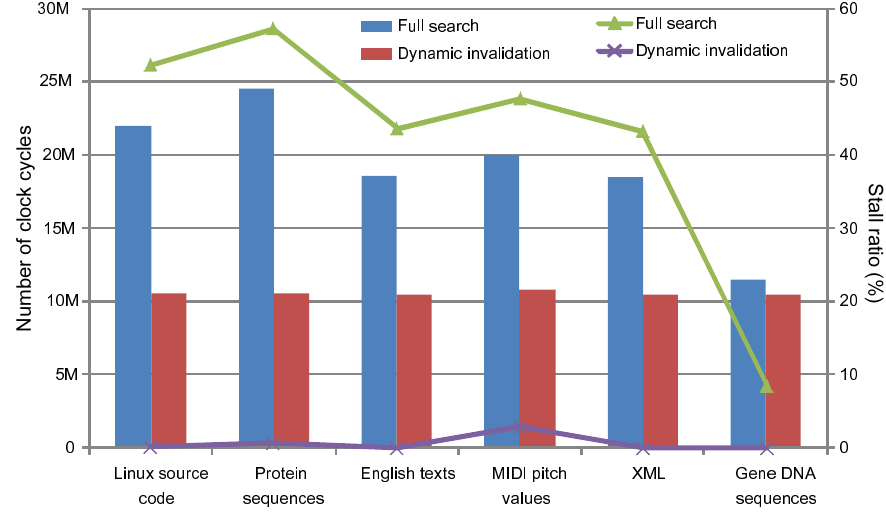
Figure 12. Stall cycles and the ratios of LCA-DLT with/without the dynamic invalidation and the lazy compression